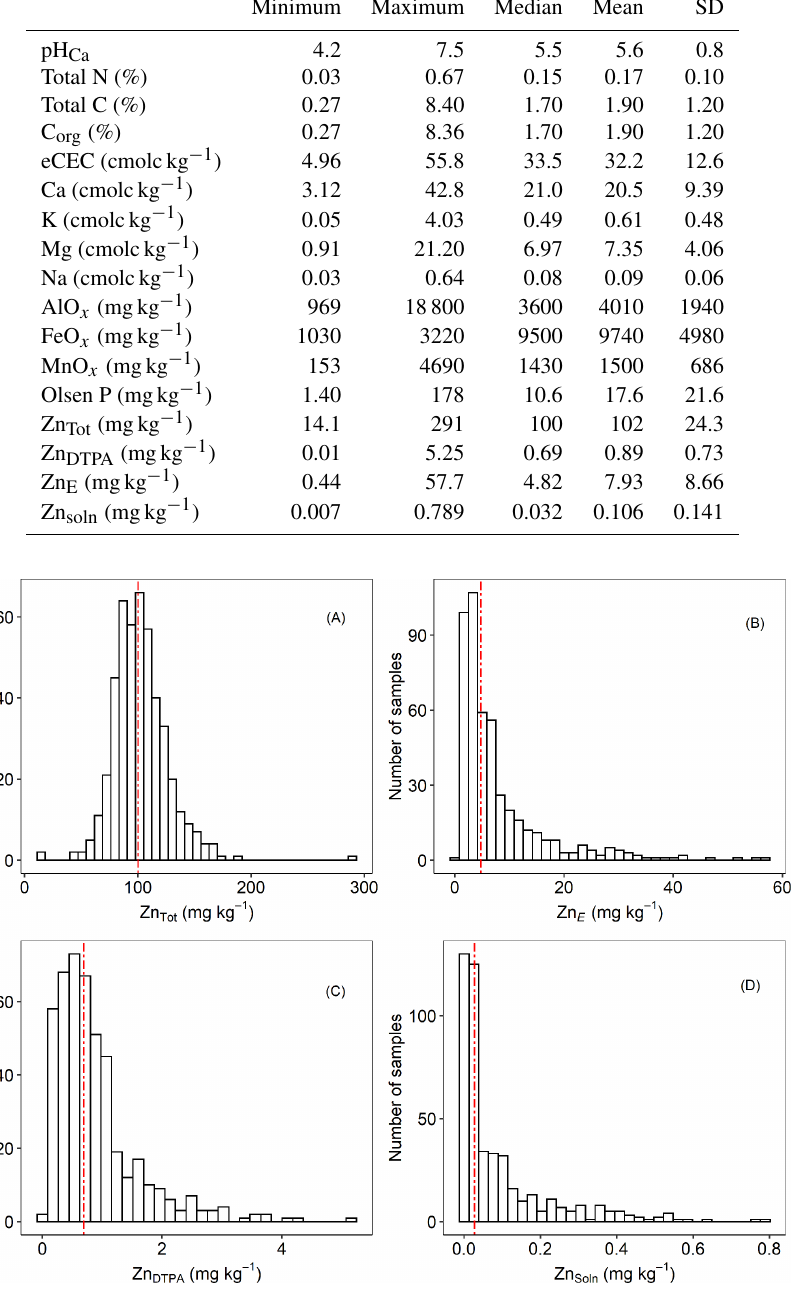
Figure 2. Frequency distributions of (a) Zn Tot , (b) Zn E , (c) Zn DTPA and (d) Zn Soln concentrations in agricultural topsoil samples from the Amhara Region, Ethiopia. Vertical dashed lines represent median